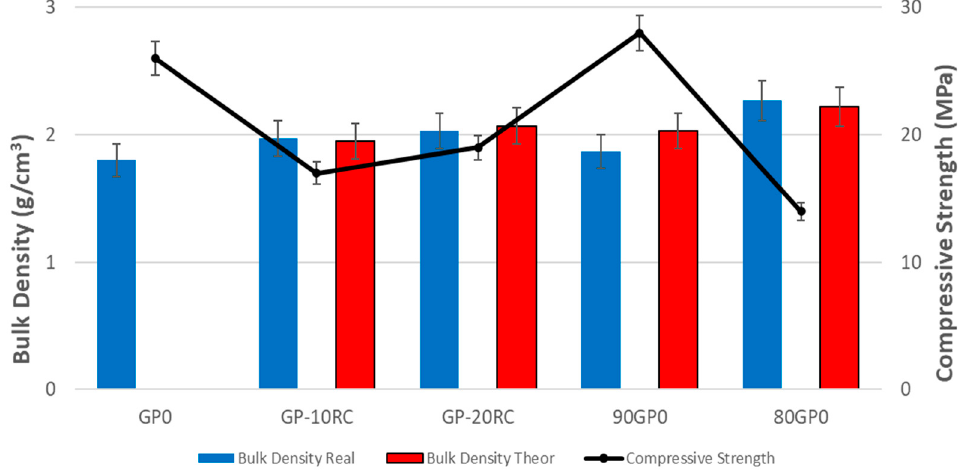
Figure 7. Compressive strength compared with density (theoretical values and calculated values) for all of the geopolymers after 28 days of curing time.